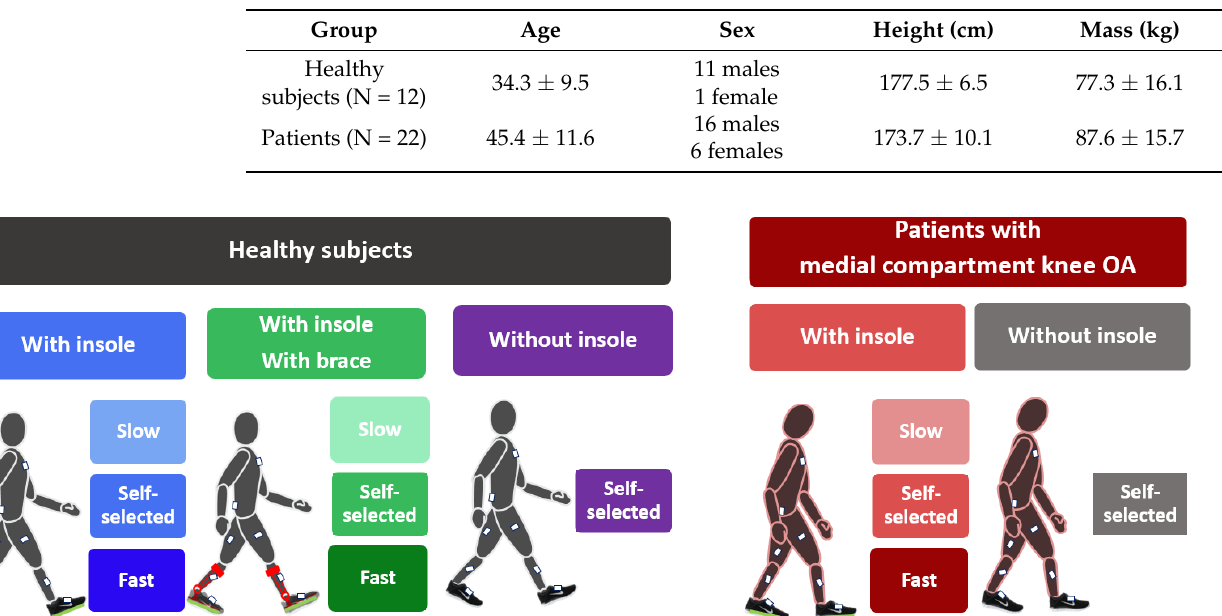
Table 1. Participant demographics.